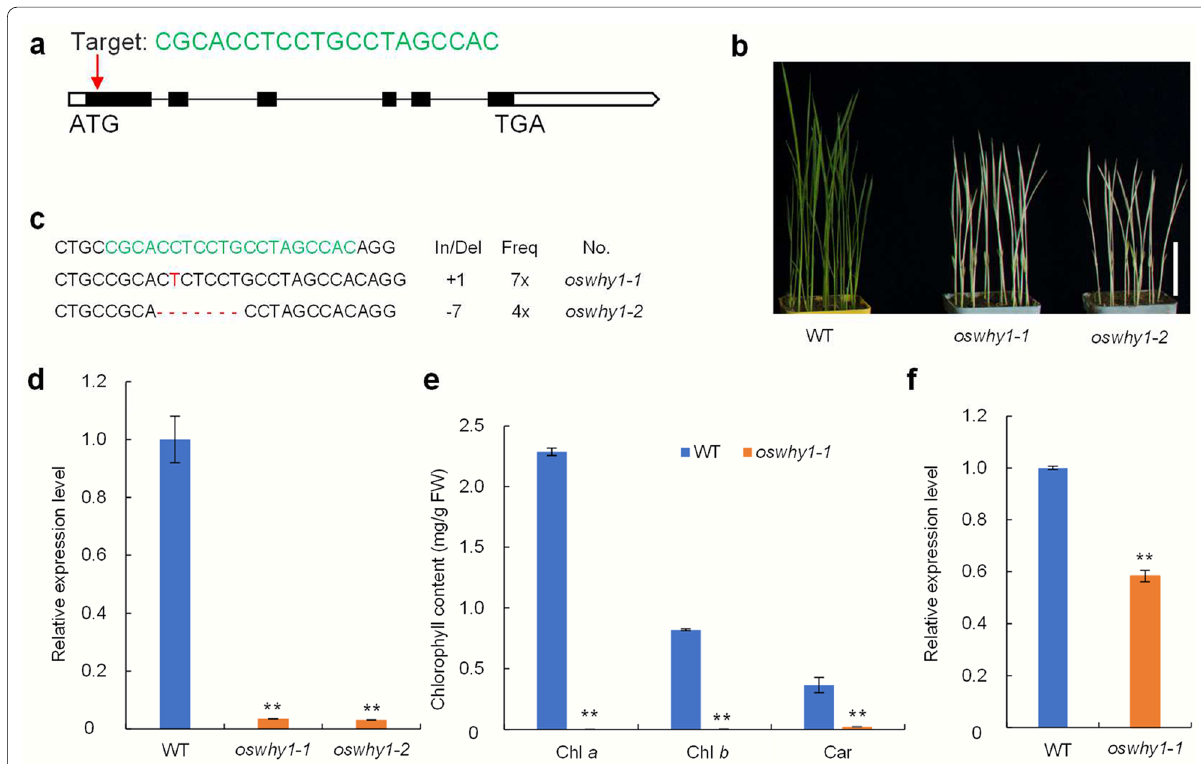
Fig. 2 Disruption of OsWHY1 function causes an albino-lethal phenotype at the seedling stage. a Schematic diagram showing the target site of OsWHY1 by the CRISPR/Cas9 system. The target sequences within the first exon of OsWHY1 are marked in green. b Phenotypes of the wild-type (WT) and the oswhy1 mutant at the two-leaf stage. Seedlings were grown in a growth chamber with 14 h of light (300 μmol photons m − 2 s − 1 ) and 10 h of darkness at constant temperatures of 30 °C. Bar 3 cm. c Two modes of mutation in the oswhy1 mutants. The oswhy1-1 mutant is = an insertion mutation, and the oswhy1-2 is a deletion mutation. d Relative OsWHY1 transcript levels in the WT and oswhy1 plants. The OsWHY1 transcript levels in the WT were set to 1. e The contents of chlorophyll a (Chl a ), chlorophyll b (Chl b ), and carotenoid (Car) in the WT and oswhy1-1 plants at the two-leaf stage. f Relative OsTRX z transcript levels in the WT and oswhy1-1 . Data are the